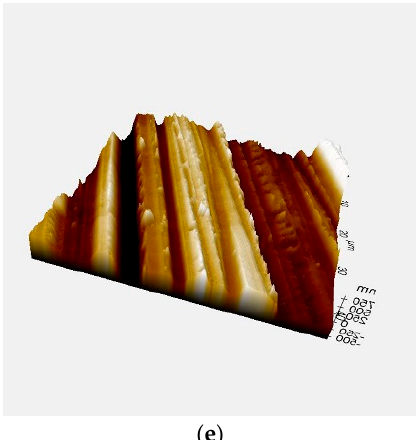
Figure 2. Surface after plasma treatment (45-µm × 45-µm magnification). ( a ) Control (no treatment), ( b ) P0 group (immediately after treatment), ( c ) P1 group (24 h after treatment), ( d ) P2 group (48 h after treatment), ( e ) P3 group (72 h after treatment).